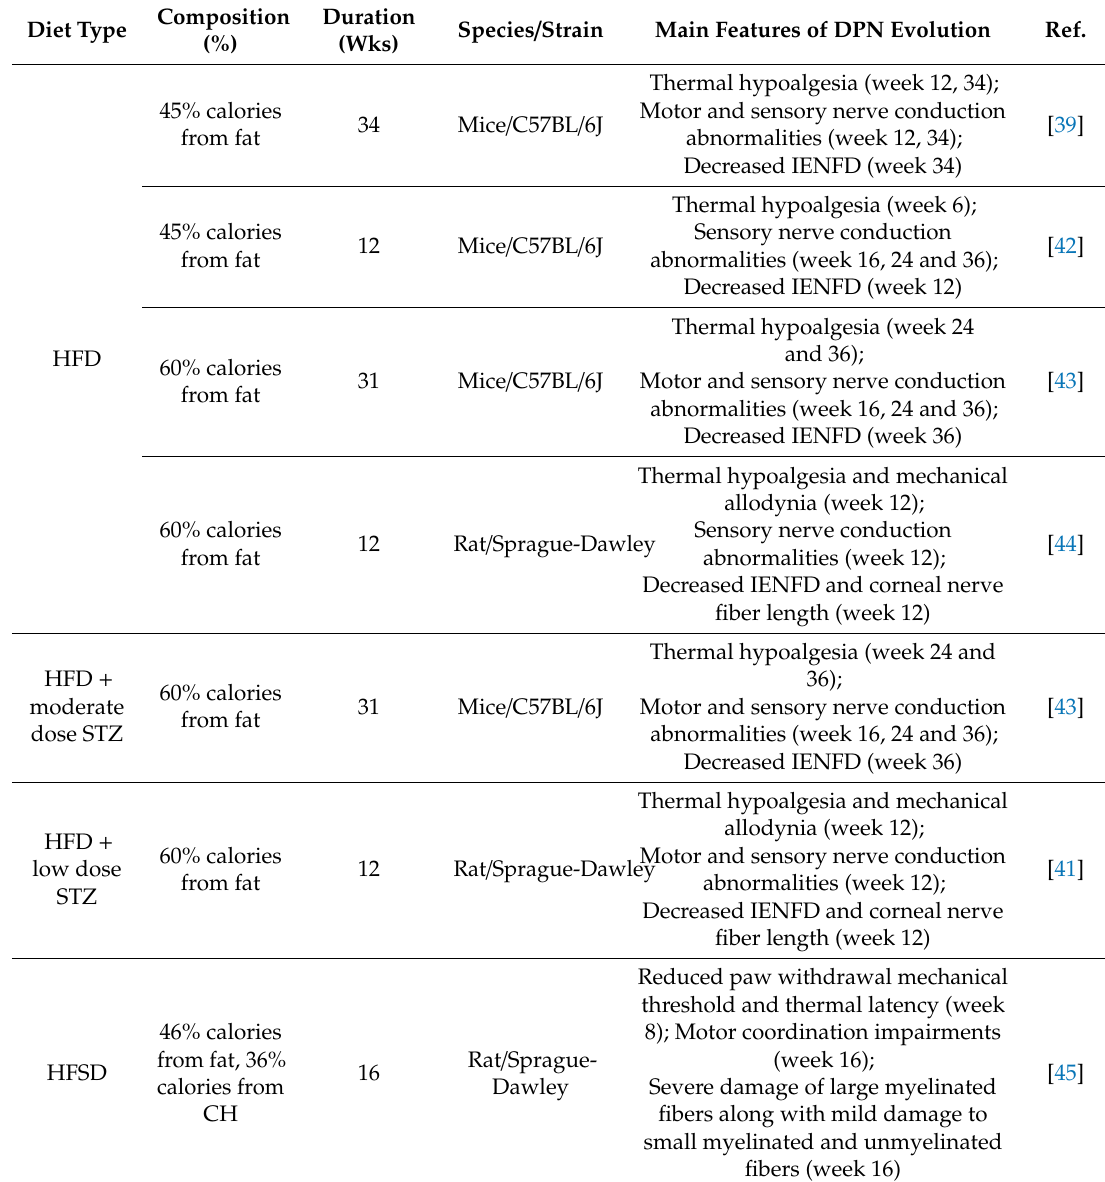
Table 1. Main features of diet-induced rodent models of diabetic peripheral